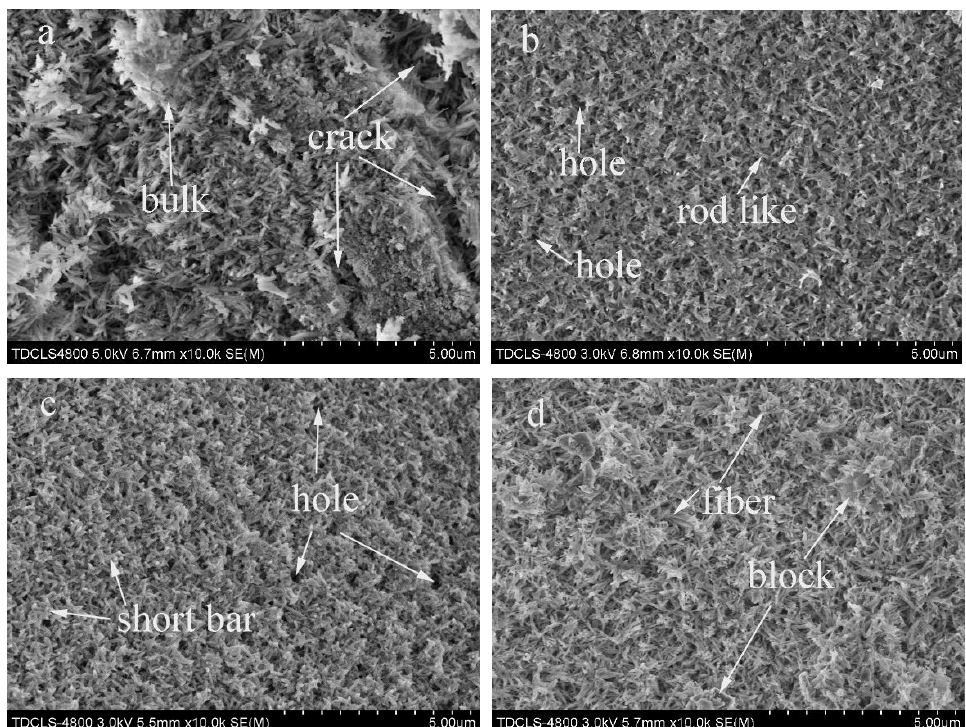
Figure 3. Surface morphology and EDS of SiC-hydroxyapatite coatings with different SiC particle sizes: ( a ) hydroxyapatite; ( b ) hydroxyapatite + 50 nm SiC; ( c ) hydroxyapatite + 100 nm SiC; ( d ) hydroxyapatite + 200 nm SiC.